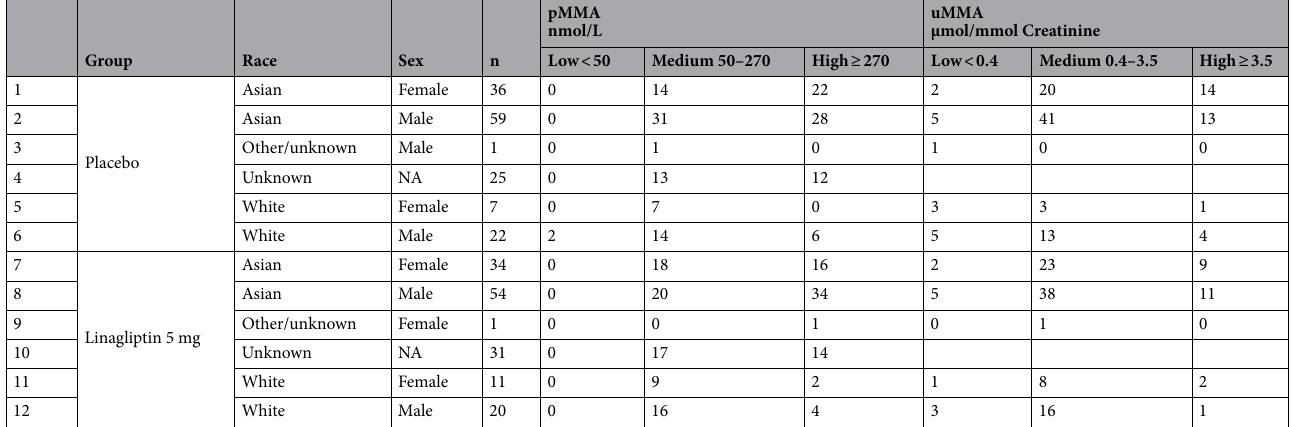
Table 4. Patient characteristics and pMMA and uMMA values of a subset of individuals from the MARLINA trial. Number of individuals with low, medium and high pMMA and uMMA levels grouped by Race and Sex. NA not applicable; pMMA plasma methylmalonic acid; uMMA urine methylmalonic